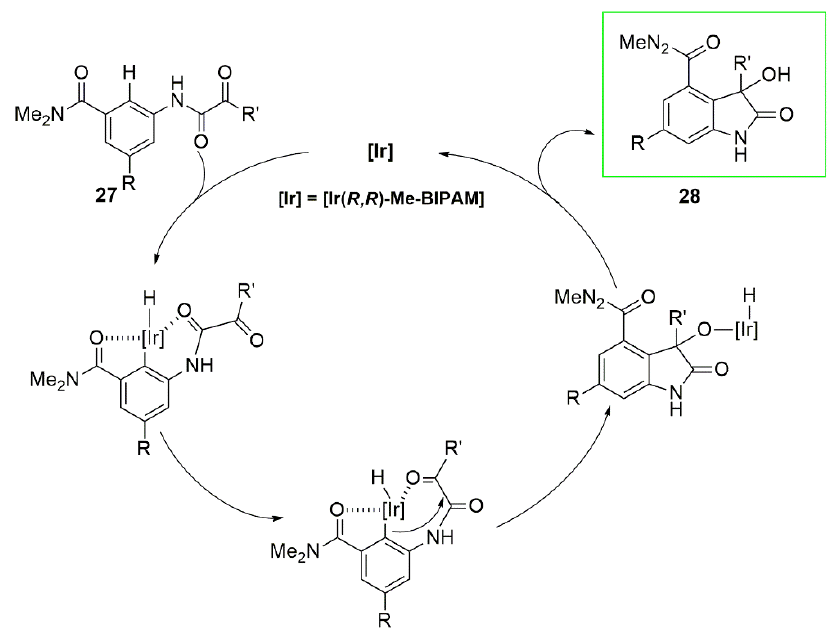
Figure 17 . Catalytic cycle of intramolecular asymmetric hydroarylation of α -ketoamides ( 27 ) cata- lyzed by [Ir(R,R)-Me-BIPAM].